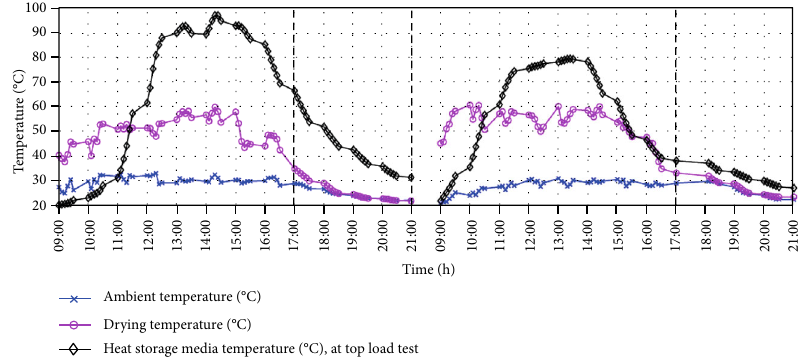
Figure 10: Variation of temperature of load drying tests with